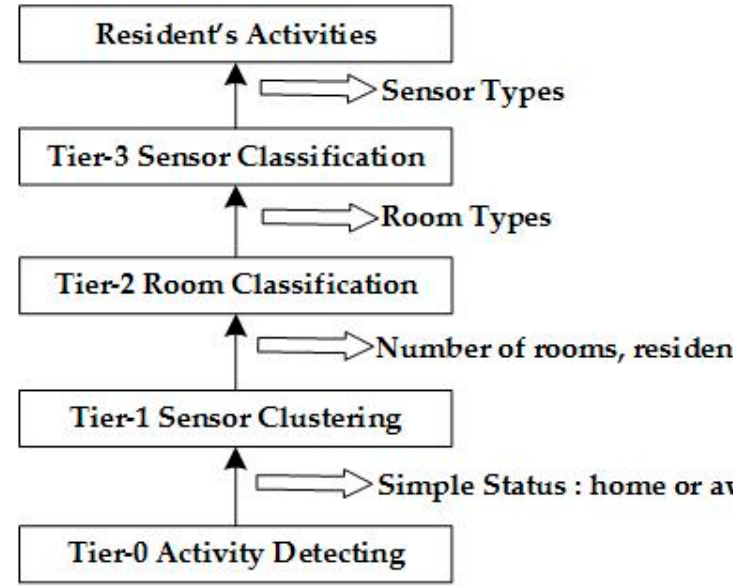
Figure 1. Four tiers in the FATS (Fingerprint And Timing ‐ based Snooping) attack model.